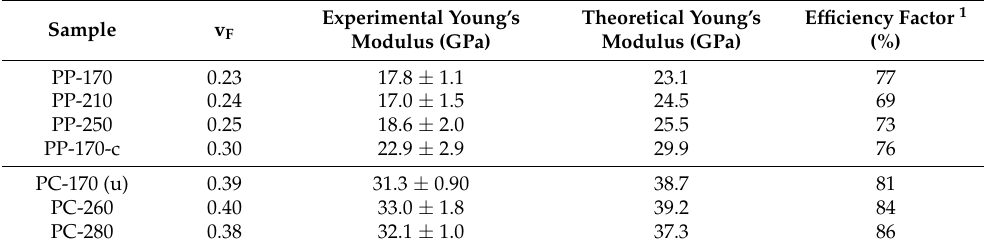
Table 8. Predicted and measured Young’s moduli of UD BF-PP and BF-PC composites.